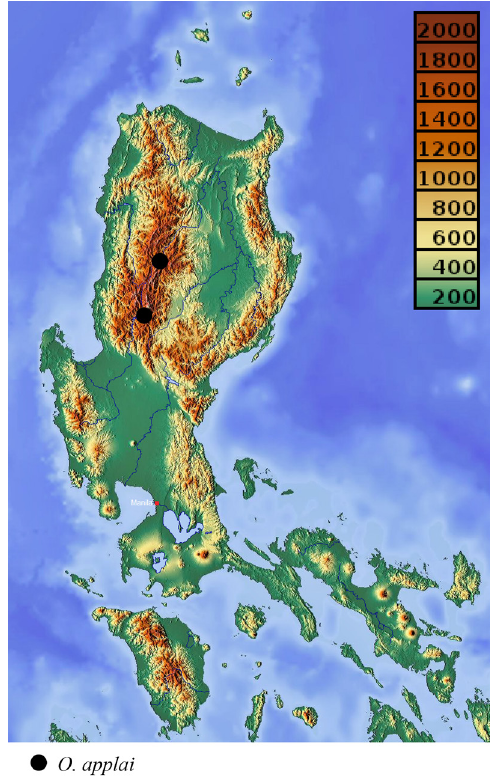
Fig. 4. Otraleus applai sp. nov. Distribution map in